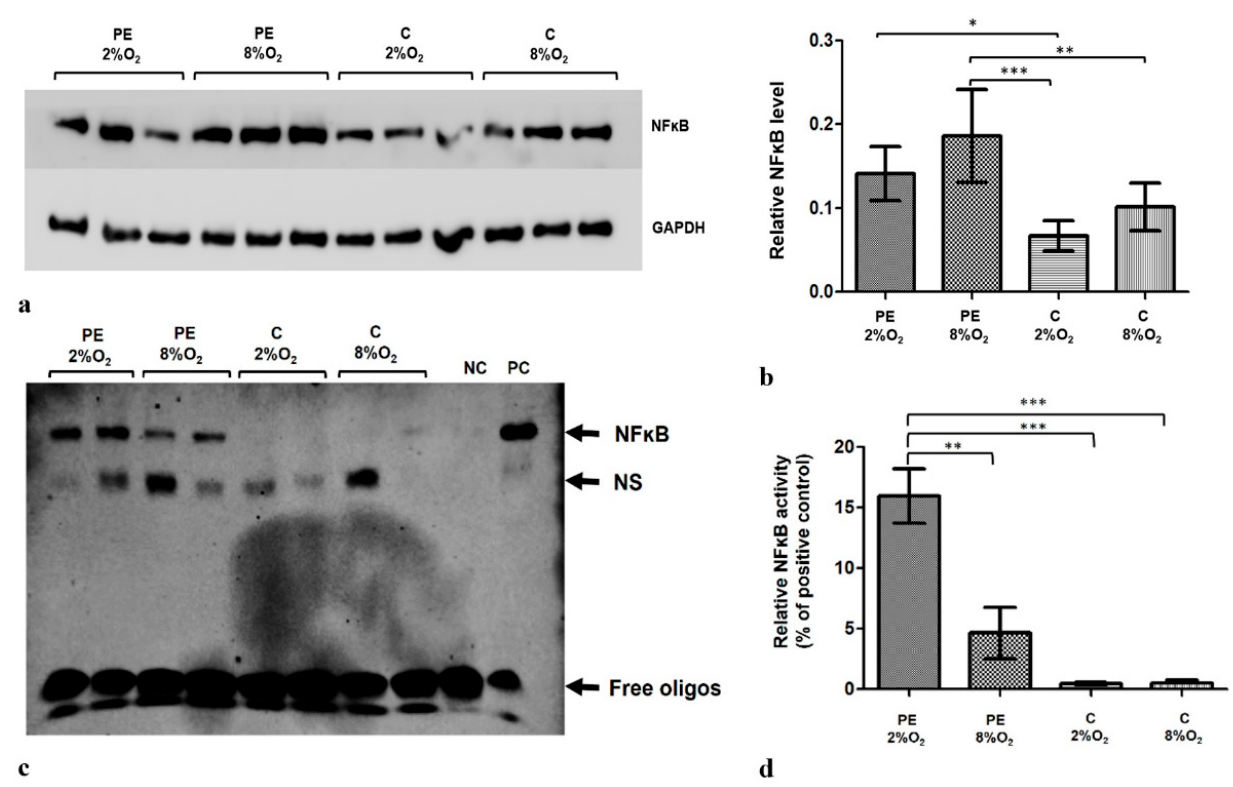
Figure 1. The differences in NF κ B level and activity between HTR8/SVneo cells incubated in hypoxia and normoxia with medium containing 1% serum from preeclamptic (PE) or normotensive women (C). ( a ) Western blot membrane showing bands for NF κ B and the control GAPDH protein; ( b ) NF κ B level relative to GAPDH and Tubulin levels; the p -value was calculated by ANOVA with the Bonferroni post hoc test; * p < 0.05; ** p < 0.01; *** p < 0.001. Data are presented as mean ± SEM; ( n = 3 experiments) ( c ) EMSA results. ( d ) EMSA results present as the relative NF κ B activity calculated as percent of positive EMSA control; the p -value was calculated by the ANOVA with the Bonferroni post hoc test; ** p < 0.01; *** p < 0.001. Data are presented as mean and ± SEM; ( n = 3 experiments). Abbreviations: PE 2% O 2 —hypoxia (2% O 2 ), medium containing 1% serum from preeclamptic mothers; PE 8% O 2 —normoxia (8% O 2 ), 1% serum from preeclamptic mothers; C 2% O 2 —hypoxia (2% O 2 ), 1% serum from normotensive pregnant women; C 8% O 2 —normoxia (8% O 2 ), 1% serum from normotensive pregnant women; NC—negative control; PC—positive control; NS—nonspecific band.